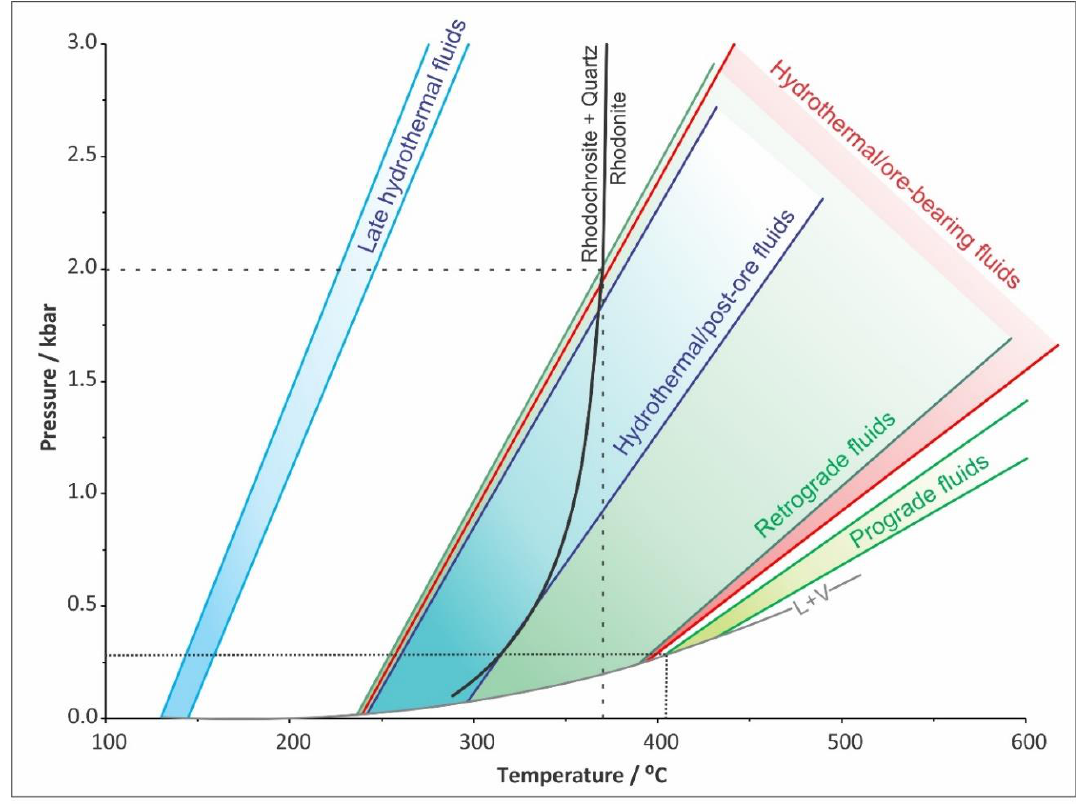
Figure 14. Pressure – temperature (P – T) diagram showing the ranges of isochores obtained from fluid